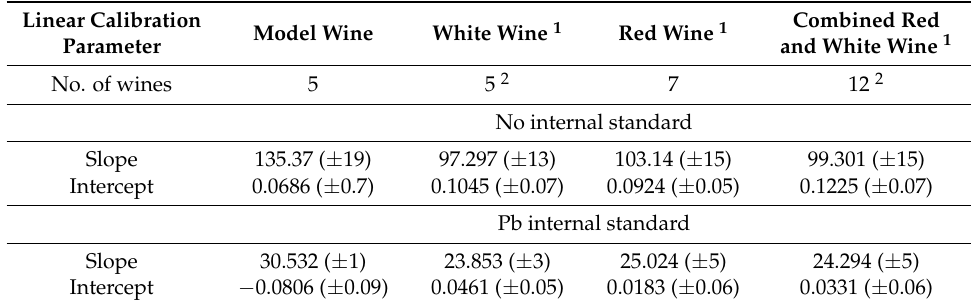
Table 2. The slope and intercept of composite labile Cu calibration graphs generated in oxidized wines and model wine. The quoted uncertainty is the standard deviation.